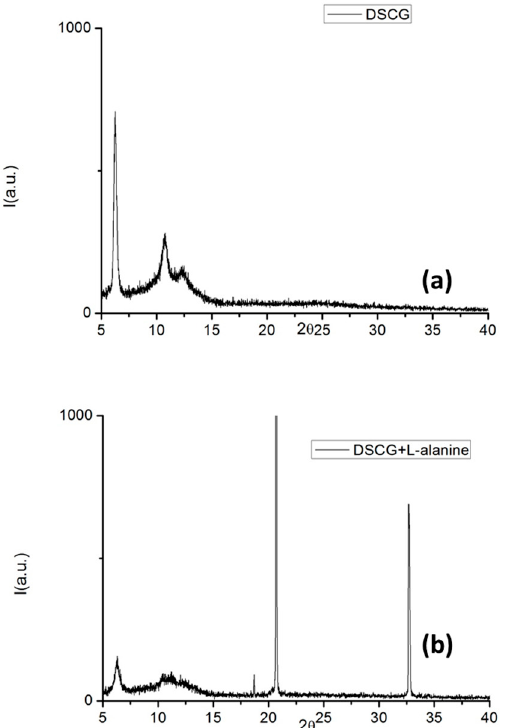
Figure 15. XRD spectra of ( a ) pure DSCG and ( b ) DSCG doped with L-alanine.